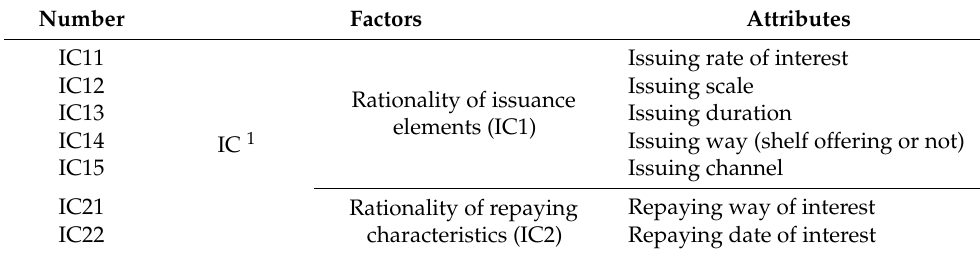
Table 3. Mediating factors and attributes (Source: Experts’